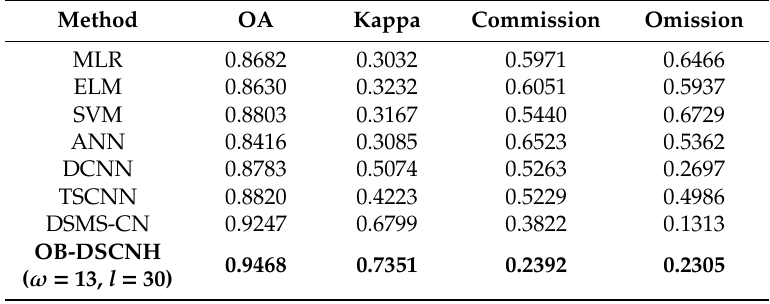
Table 3. Accuracy of the di ff erent change detection methods on the second dataset.